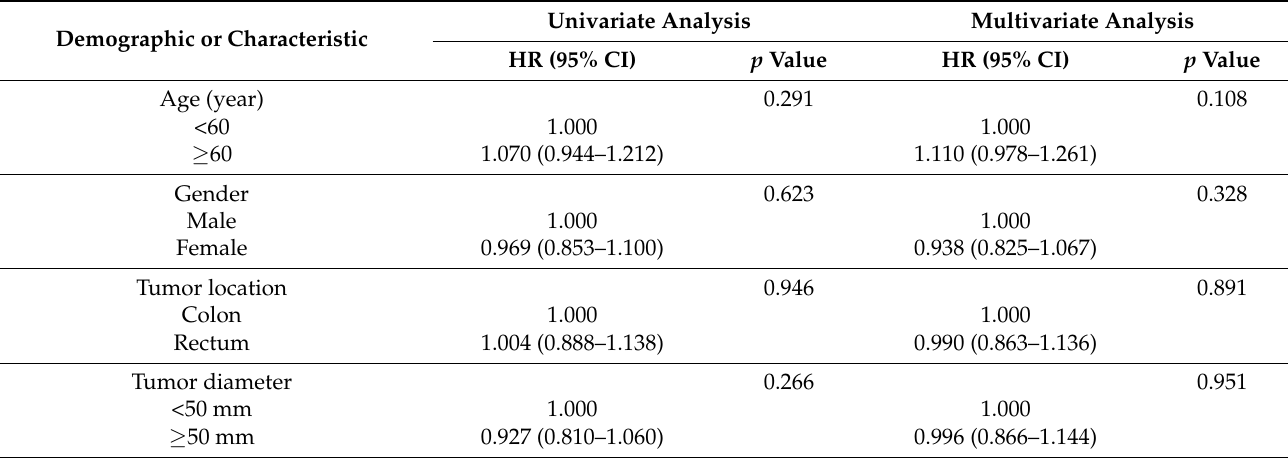
Table 5. Association between predictive factors and disease-free survival of CRC in the validation